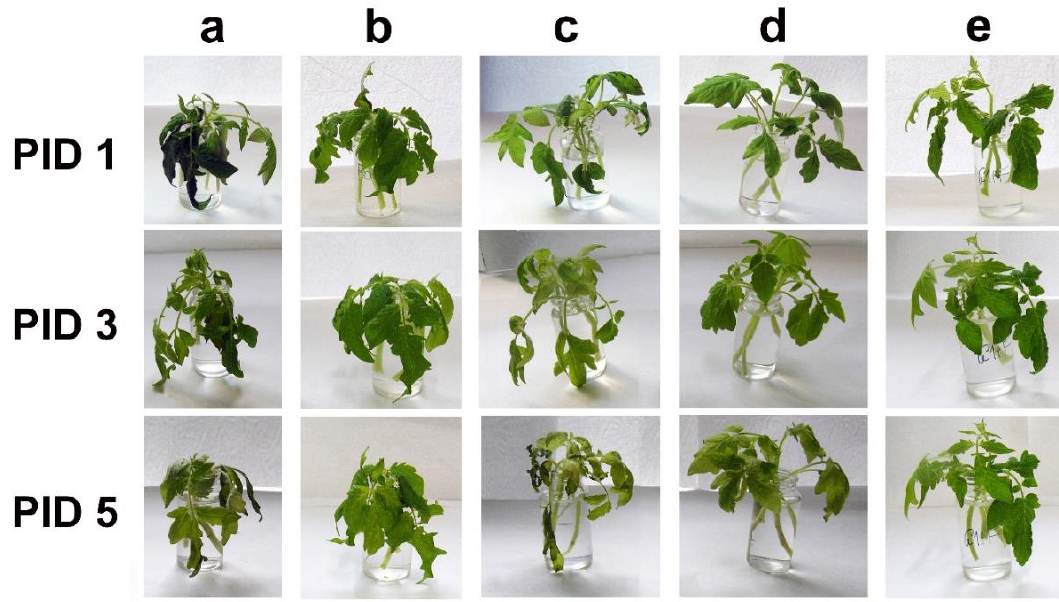
Figure 4. Representative photos showing results of the F. oxysporum wilting test on detached tomato seedlings. Seedlings were inoculated by the tomato wilt pathogen F. oxysporum f. sp . lycopersici , F37 by immersion of stems in a suspension of conidia, 3 × 10 6 (control) or in portions of the same suspension supplemented with either Folicur ® only (at 0.05 or 0.005 µ g / mL) or fungicide at 0.005 µ g / mL combined with WAMP-2 derived peptides (each at 200 µ g / mL). ( a ) Control treatment (only F. oxysporum ); ( b ) Folicur ® , 0.05 µ g / mL; ( c ) Folicur ® , 0.005 µ g / mL; ( d ) Folicur ® , 0.005 µ g / mL + WAMP-C; ( e ) Folicur ® , 0.005 µ g / mL + WAMP-G1. PID 1, PID 3 and PID 5 are the first, third, and fifth post-inoculation days,